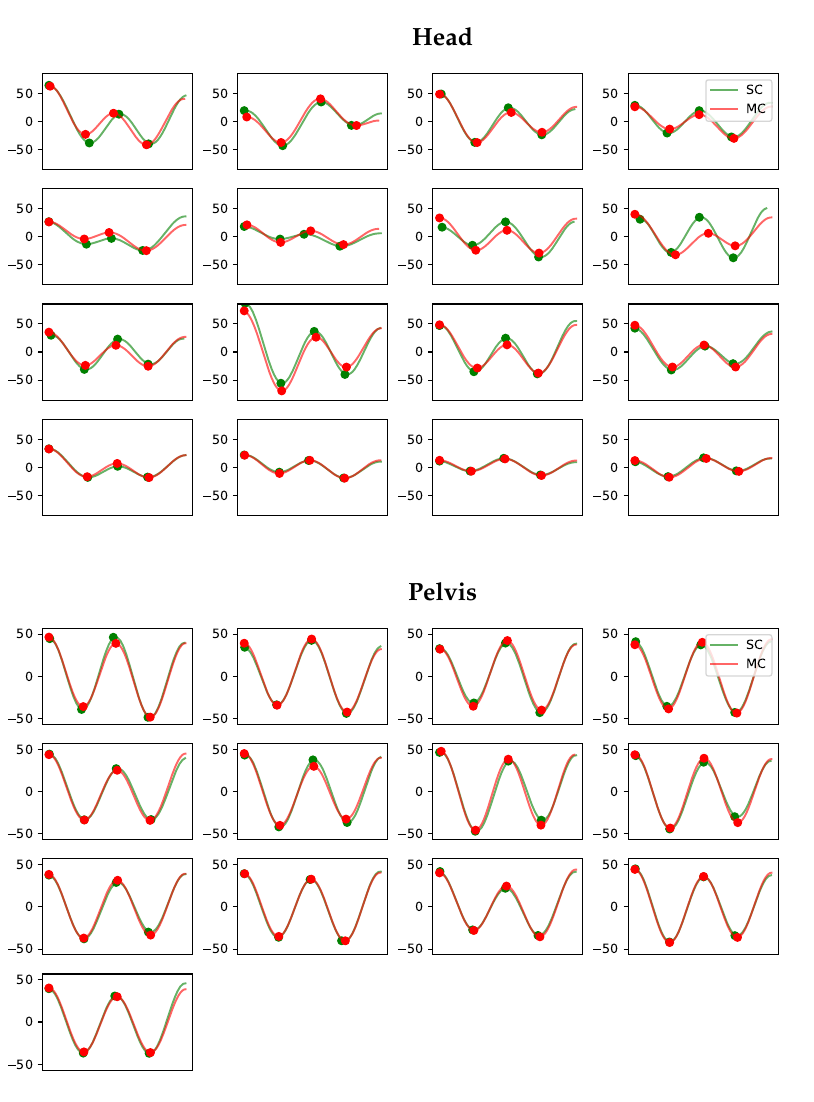
Figure A1. Vertical displacement signals per stride for the head and pelvis for horse 1. Each subplot contains the matched stride segments for the single-camera markerless system (SC) in green and the multi-camera marker-based system (MC) in red. The y-axis shows the vertical displacement in millimeters. The four dots on each curve indicate the positions of the two peaks and two valleys extracted using the approach in Section